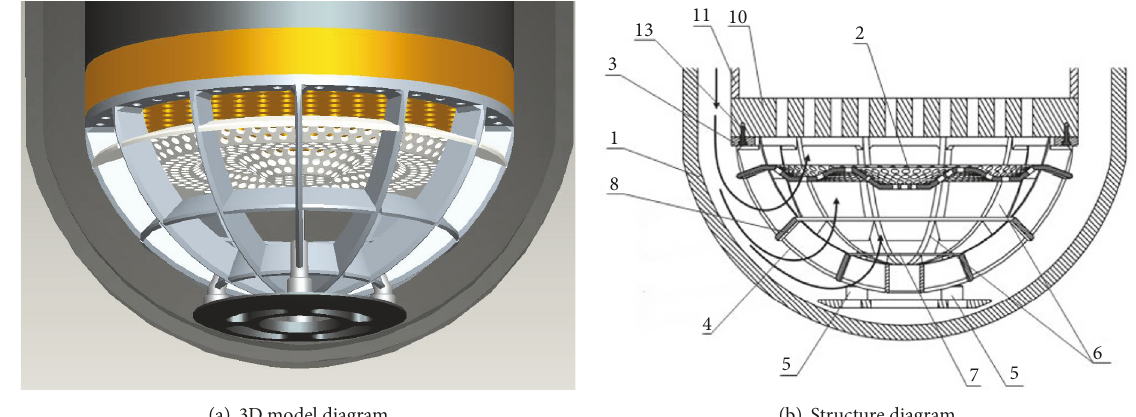
Figure 9: Innovative solution. (a) 3D model diagram. (b) Structure